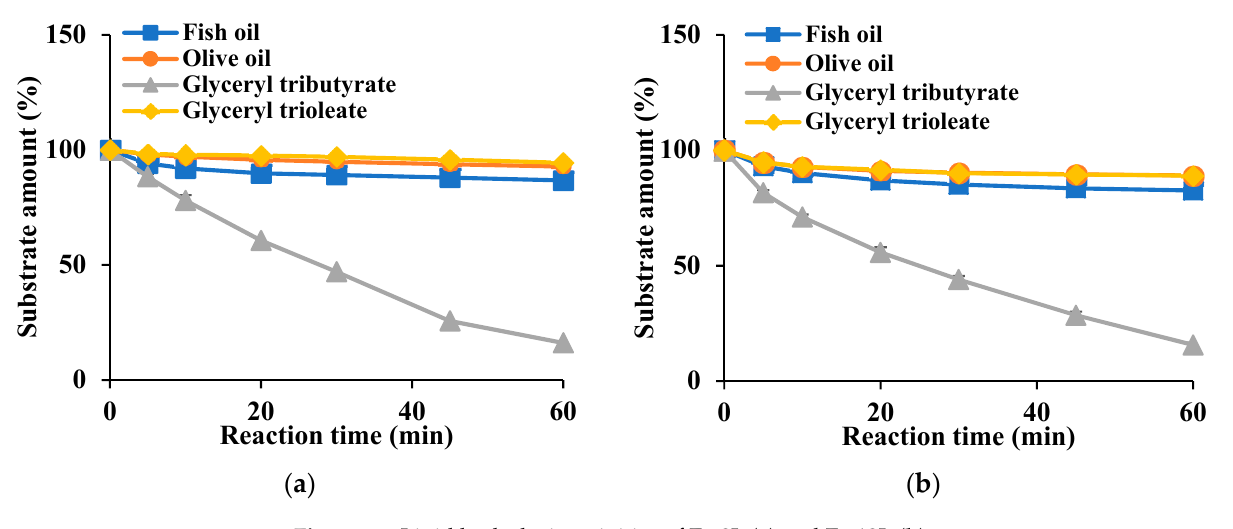
Figure 11. Lipid hydrolysis activities of Est8L ( a ) and Est13L ( b ). In enantioselectivity, Est8L hydrolyzed the S -form with 10.1% higher activity than the R -form, suggesting preferences for the S -form, whereas Est13L showed no selectivity for the enantiomers (Figure 12). In the t-test, it was observed that the enantioselectivity for S -form was significant compared to R -form with a p -value < 0.05.